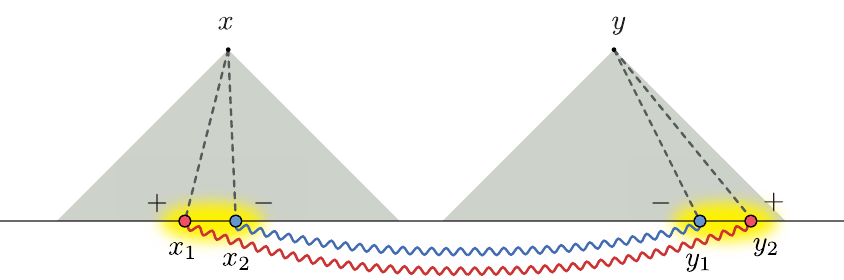
Figure 6 . Graphical explanation of how a non-zero out-of-horizon correlation C (cid:5) ( x; y ; t ) emerges due to the presence of long-range initial fermionic correlations. The coloured links depict the corre- lation C F ( x 1 ; x 2 ; y 1 ; y 2 ), while the black dashed lines are the fermion (i.e. soliton) propagators. + (cid:0)(cid:0) + The yellow regions show the correlation length m (cid:0) 1 of the pre-quench KG 0